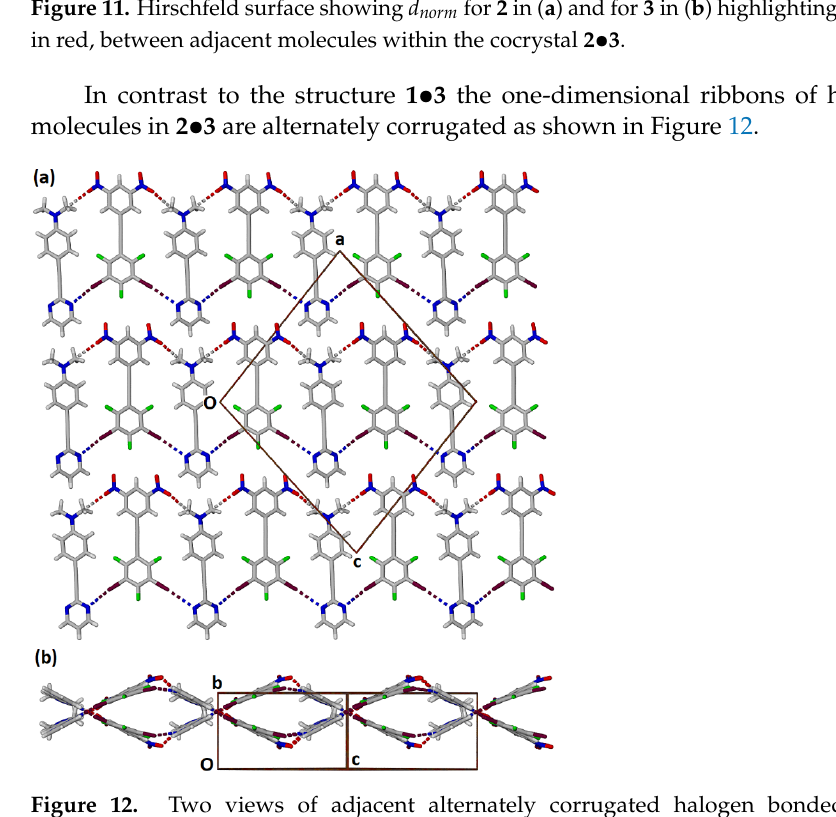
Figure 11. Hirschfeld surface showing d norm for 2 in ( a ) and for 3 in ( b ) highlighting the close contacts, in red, between adjacent molecules within the cocrystal 2 • 3 .